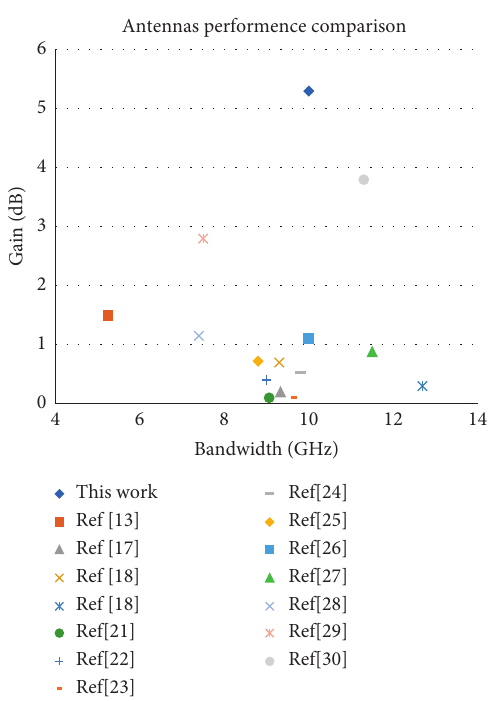
Figure 12: Comparison between the proposed design and other published works in terms of gain and bandwidth [21–30].